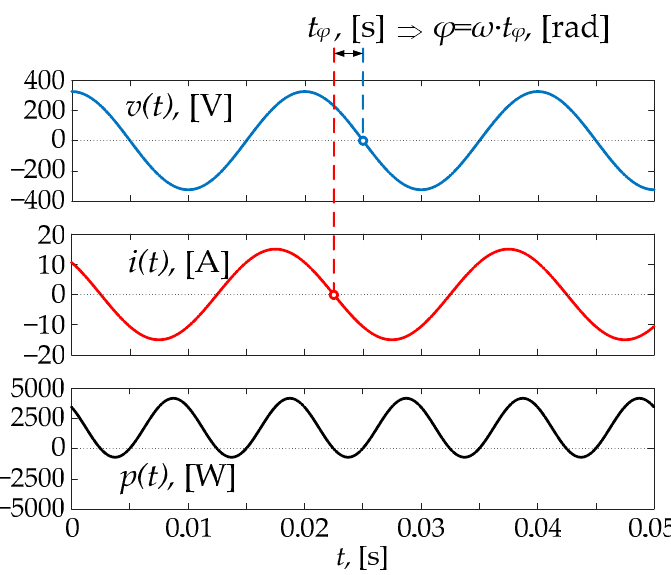
Figure 2. Example of waveforms where the frequency is 50 Hz, time delay is 0.0025 s, and phase shift is 0.25 π rad.